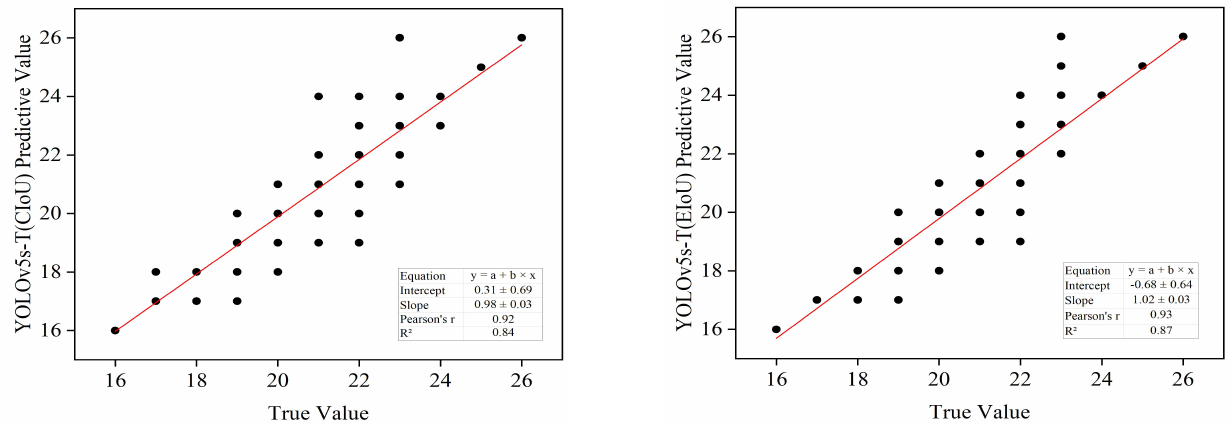
Figure 10. Statistical correlation between the predicted and true values of the proposed